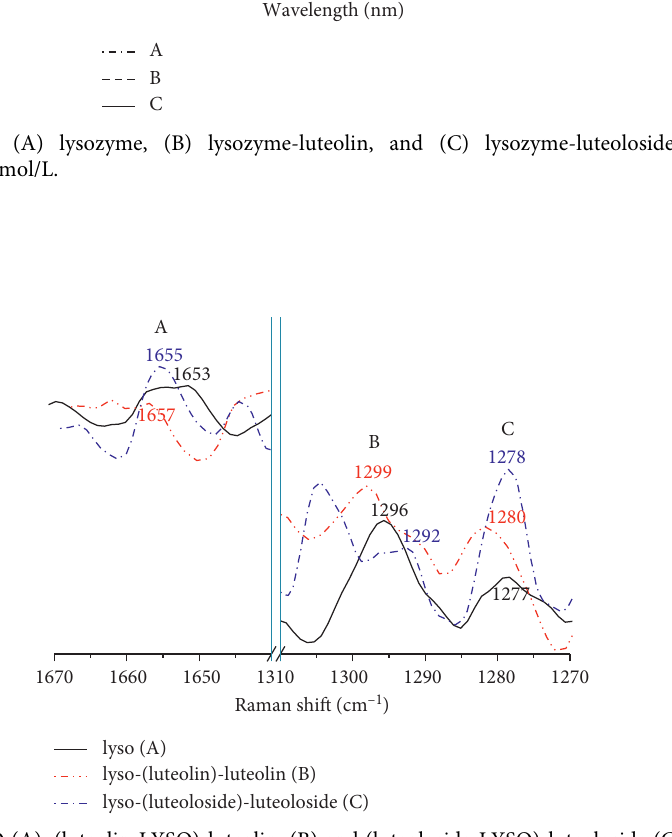
� 1 × 10 − 2 mmol/L, (LYSO)